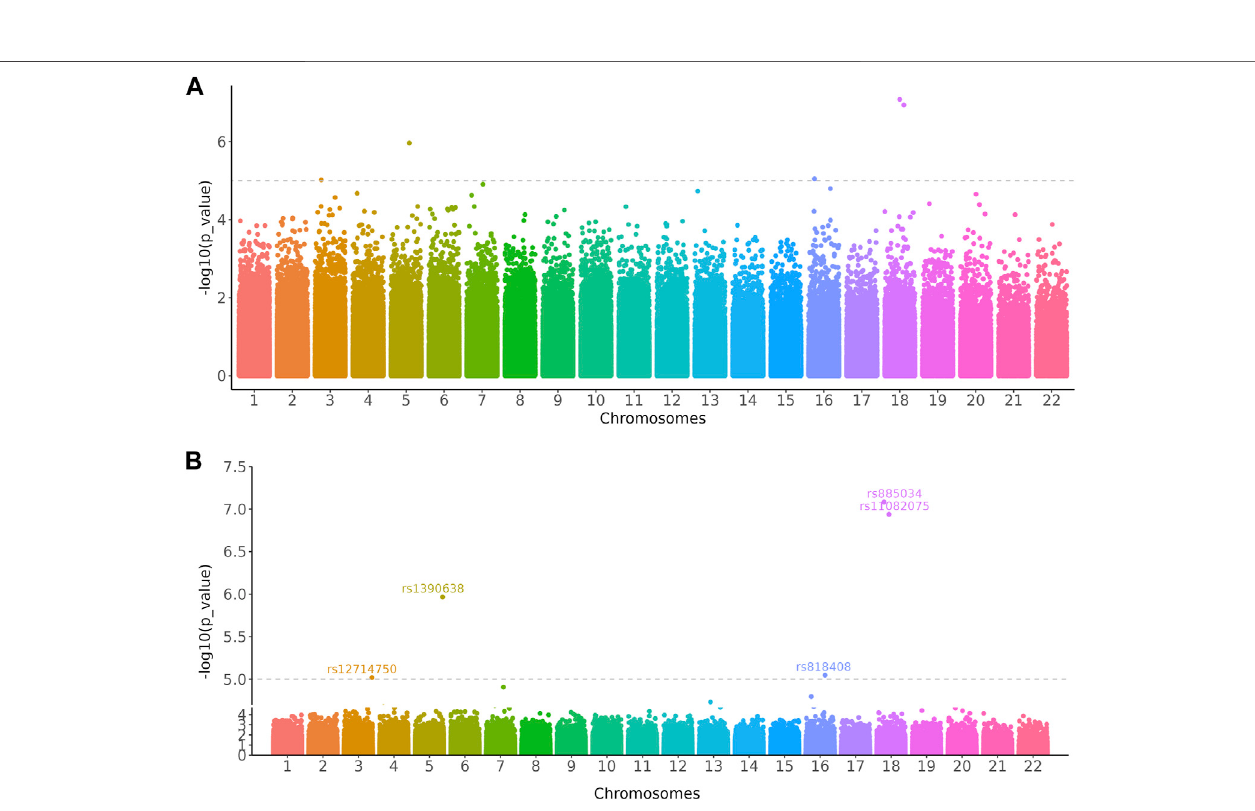
FIGURE3| Manhattan plotsshowedlocisigni fi cantlyassociatedwiththerelativeabundanceofgutbacterialdiversityusingChao1indexfrom541EastAsians. (A) OriginalManhattanplot. (B) Manhattanplotwithsigni fi cantregionzoomedin.Thedashedlinerepresentsagenome-widesuggestivelevel( p (cid:1) 1 × 10 – 5 ).TheGWASdata was downloaded from the GWAS Catalog database (Study accession: GCST90007012).